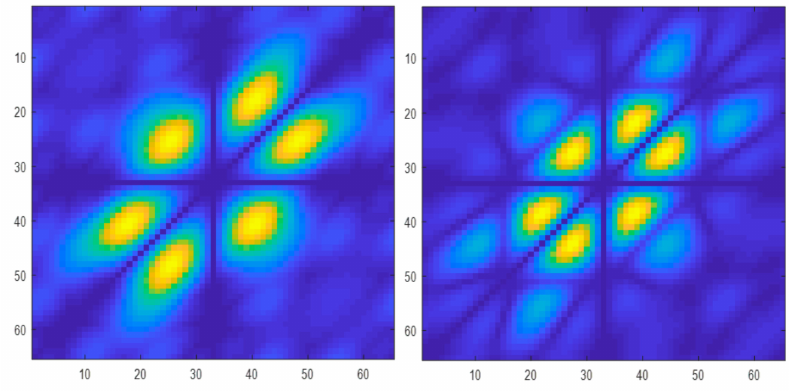
Figure 5. Bispectrum plots of ( a ) normal and ( b ) ASD classes (channel 10).